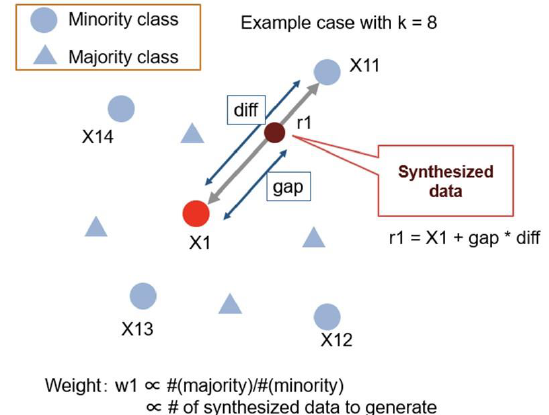
Figure 3. Working procedure of ADASYN. Source: https://github.com/minoue-xx/Oversampling- Imbalanced-Data (accessed on 20 February 2023).